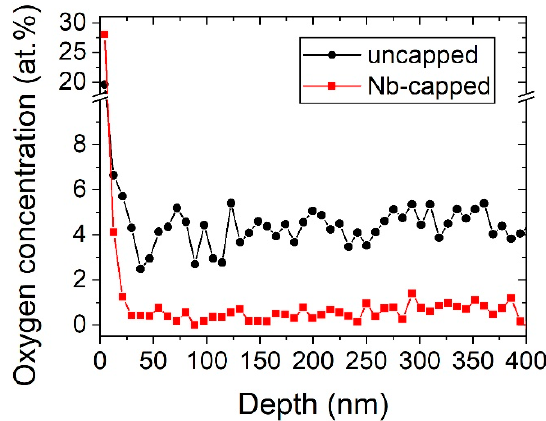
Figure 4. ToF-ERDA depth profile of the oxygen concentration for uncapped (black circle) and Nb-capped (red square) HfV 2 after four weeks of air-exposure.